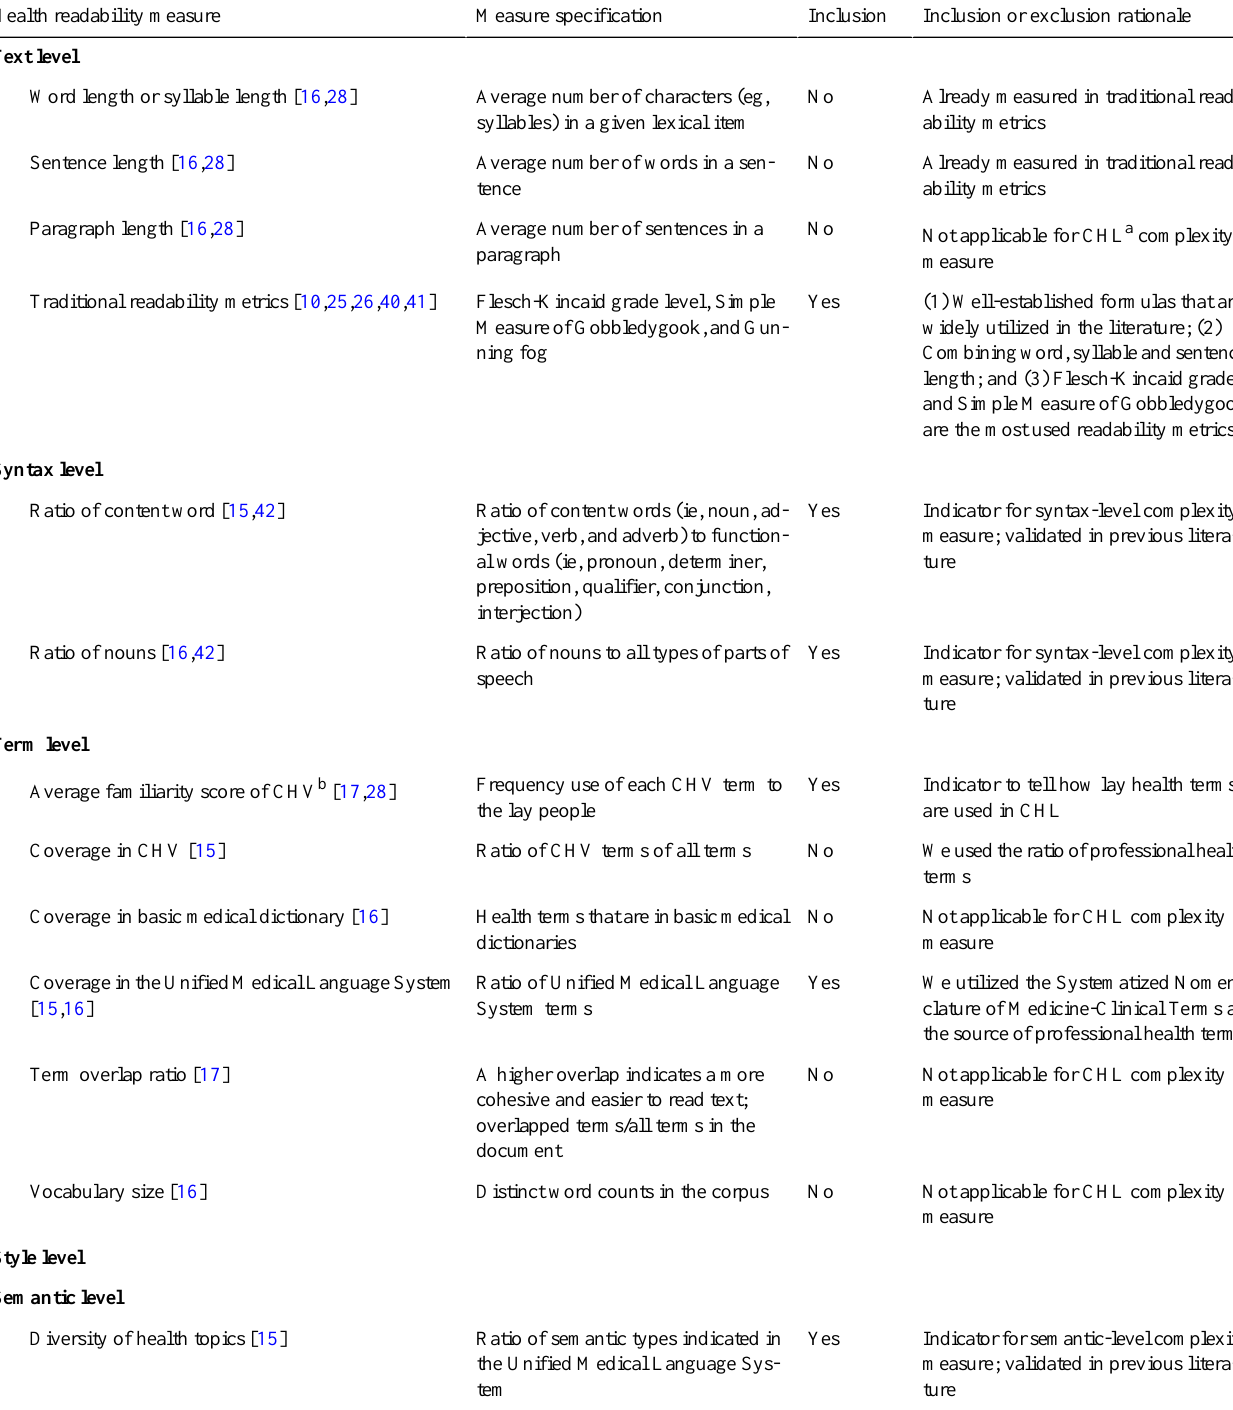
Table 1. Existing metrics for assessing health text